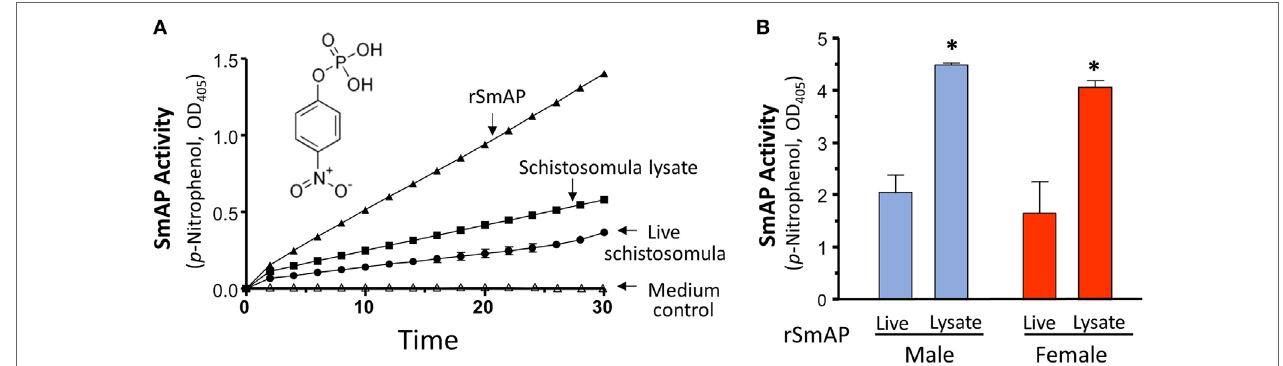
FigUre 2 | (a) Schistosoma mansoni alkaline phosphatase (SmAP) activity ( p -NPP cleavage, mean OD 405 ± SD) exhibited by recombinant protein (rSmAP, filled triangles) or live schistosomula (groups of 1,000, circles) or total lysates of equivalent numbers of schistosomula (squares). Medium in which schistosomula had been incubated for 24 h displayed essentially no activity (open triangles, “Medium control”). The chemical structure of SmAP substrate para-nitrophenyl phosphate ( p -NPP) is illustrated. (B) SmAP activity ( p -NPP cleavage/h, mean OD 405 ± SD) observed in individual live adult males (blue) or females (red) compared to that detected in total lysates of individual males or females. N ≥ 10 in each case. * indicates that lysates of male or female worms exhibit significantly greater substrate cleavage than live male or female worms; t -test, p <